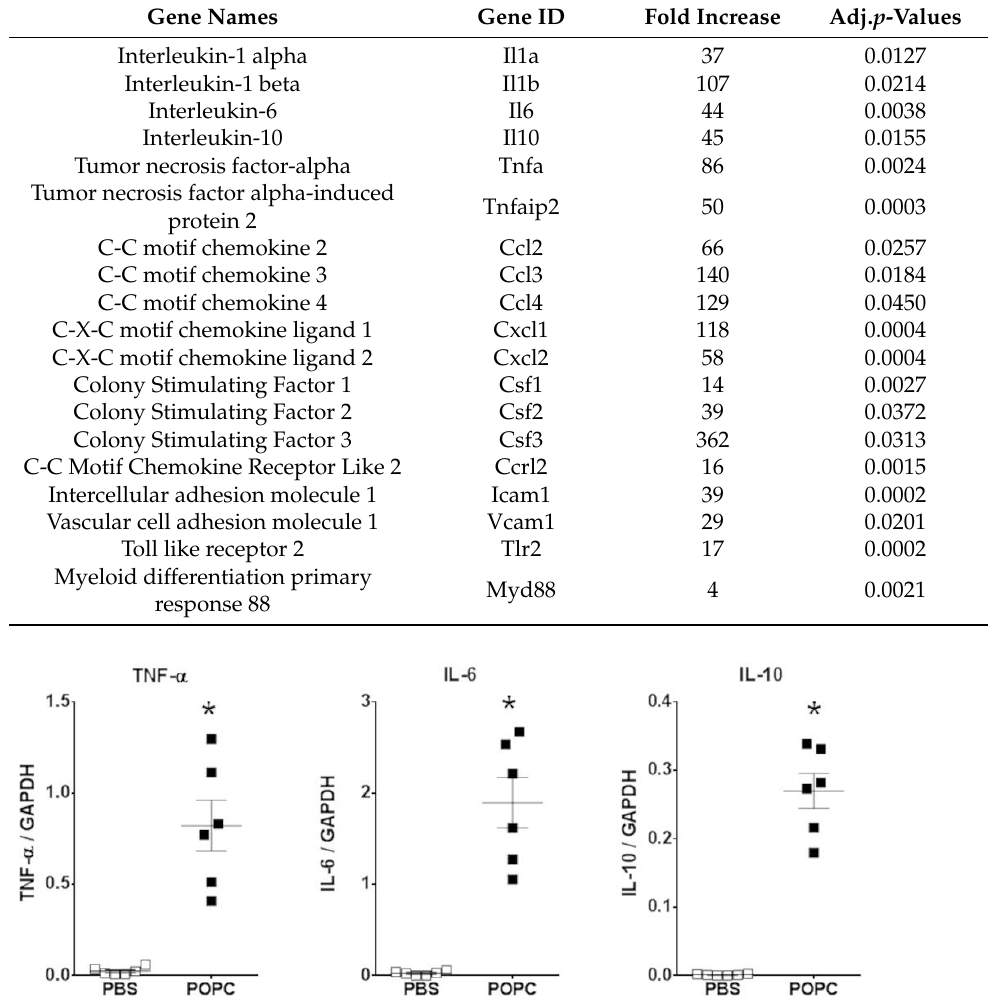
Figure 4. POPC liposome treatment increases the expression of inflammatory mediators in peritoneal cells. CD-1 mice ( n = 6 per group) were injected with POPC liposomes (400 µ g) or an equal volume of PBS (carrier). Peritoneal cells were harvested 1 h after the injection and processed for RNA isolation and qPCR analysis. Graphs show the mRNA levels for TNF- α , IL-6 and IL-10. The housekeeping gene GAPDH was used to normalize data to cDNA inputs. Results are expressed as means ± SEM, and statistical analysis for the comparison between groups was performed using unpaired Student’s t -test with * indicating p < 0.05.